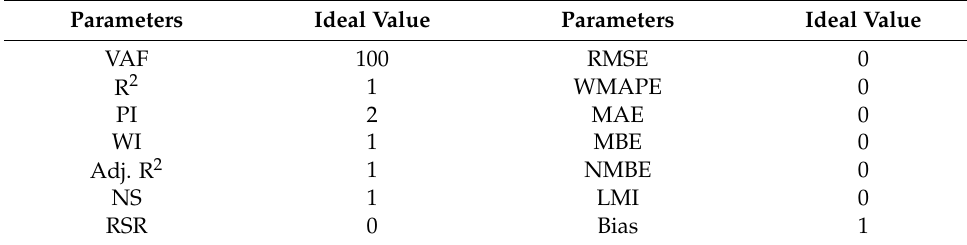
Table 5. Ideal limit of statistical parameters.